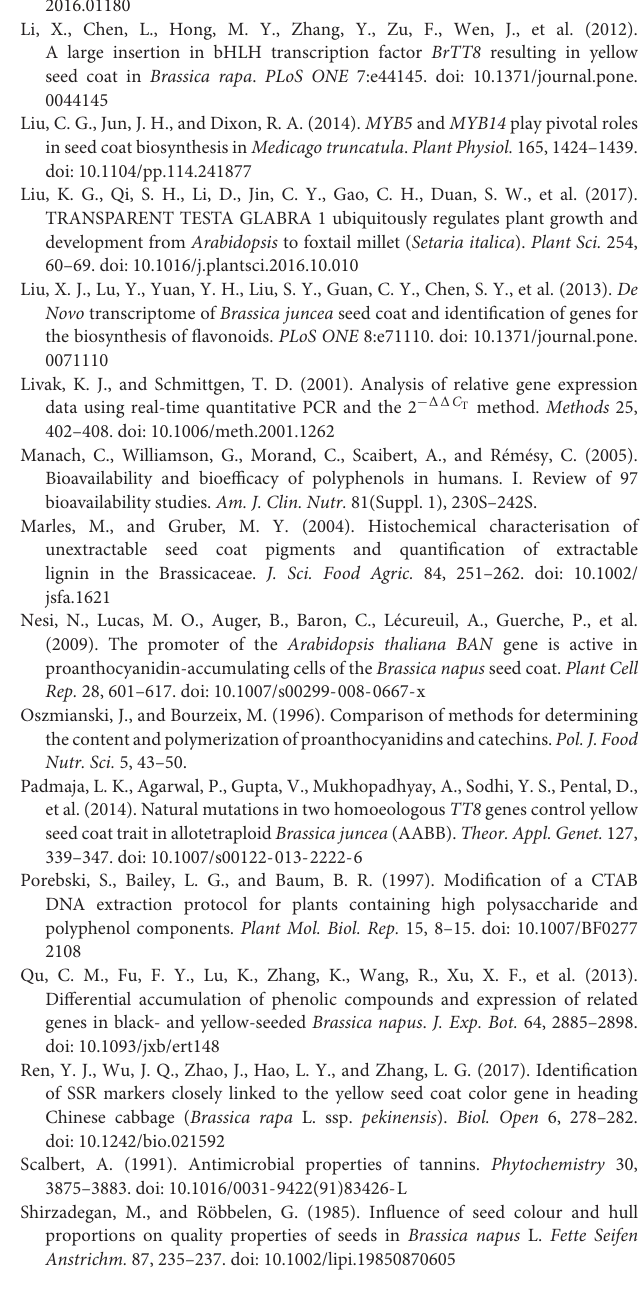
FIGURE S2 | Predicted amino acid difference sequence encoded by TTG1-B and TTG1-Y . FIGURE S3 | Diagrammatic sketch of four WD40 structures of the TTG1 protein in the brown-seeded 92S105. FIGURE S4 | Polymorphism of co-segregation marker Brsc-yettg1 in the brown-seeded parent 92S105, yellow-seeded parent 91-125 and F 2 individuals. B: brown-seeded parent 92S105, Y: yellow-seeded parent 91-125, F 2 : F 2 individuals. TABLE S1 | The summary of whole genome